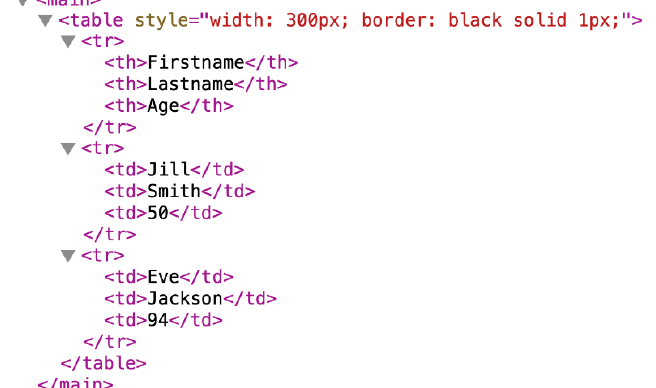
Figure 20. HTML code generated for the implementation of the getMainObjects function returning a table built using the tag function